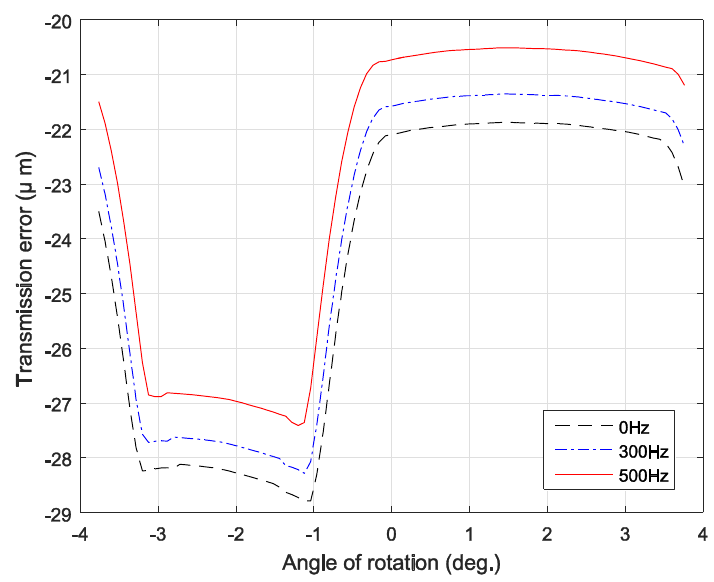
Figure 11. Transmission error depending on gear mesh frequency when torque is 140 Nm.